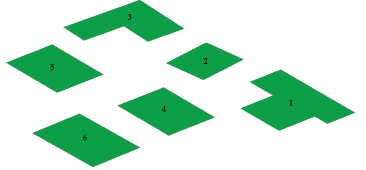
Figure 6. Polygons extracted in test area via the concave hull approach.